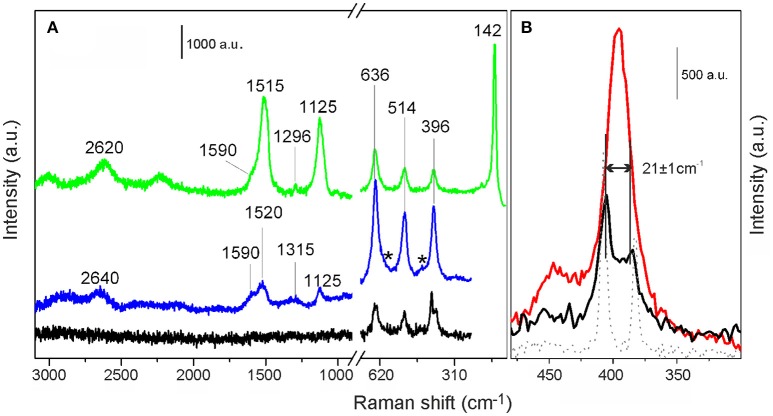
(A) Raman spectra of p-C2H2/MoS2/TiO2 recorded with the 442 nm and 514 nm laser lines, (blue and green curves, respectively). Raman spectrum of MoS2/TiO2, recorded with the 442 nm laser line (black curve) is shown for comparison. (B) Enlarged view in the 400–500 cm−1 spectral range, of MoS2/TiO2 (black curve), pure TiO2 (red curve) and pure MoS2 (gray dotted line) spectra, acquired with the 442 nm laser line.